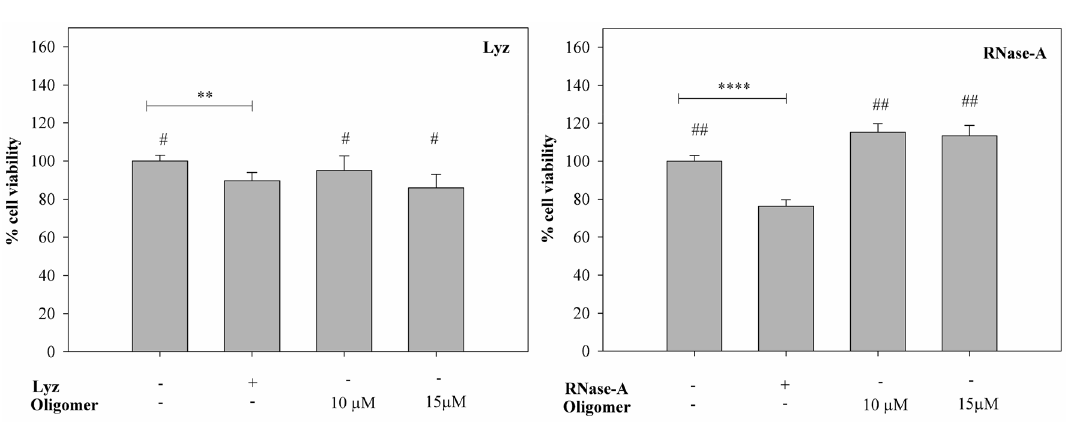
Figure 5. Cytotoxic behavior of HTL-induced protein oligomers on HeLa cells: Percent viability of cells in the presence and absence of Lyz oligomers formed on day 6 (left panel) and RNase-A oligomers (right